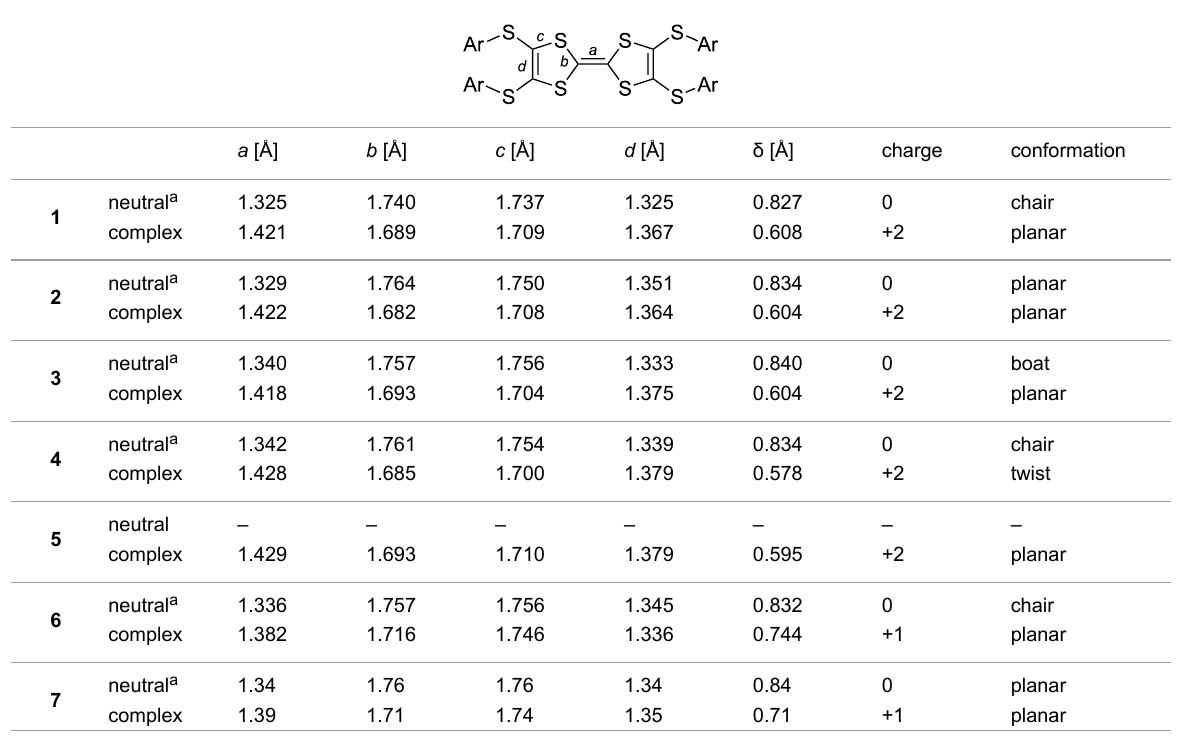
Table 3: Selected bond lengths, calculated charge, and conformations of